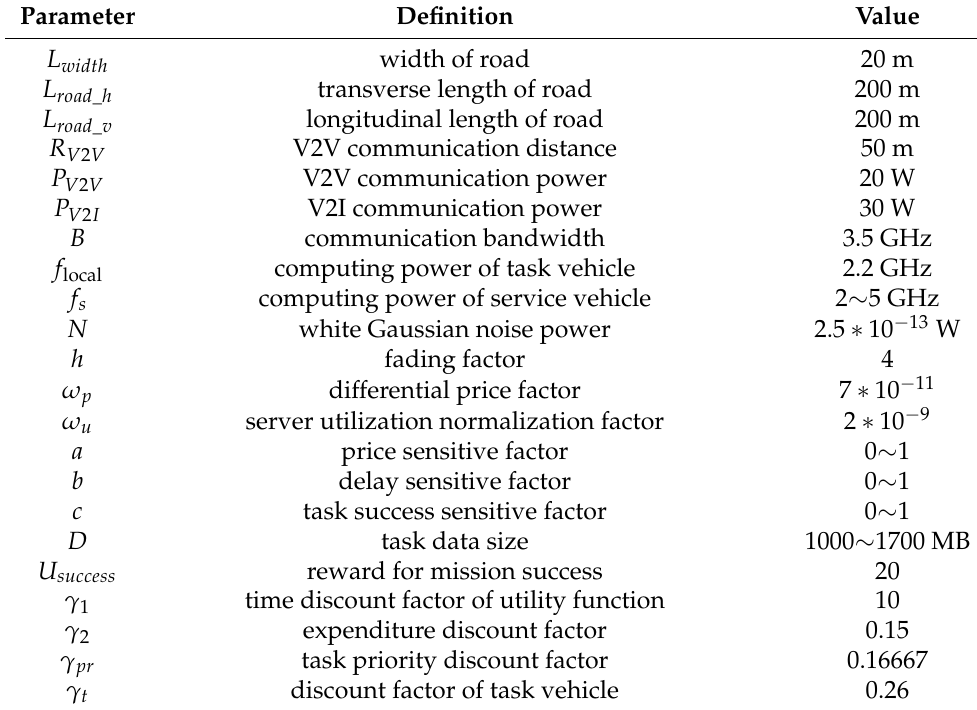
Table 1. Experimental parameters of Stackelberg–MADDPG offloading